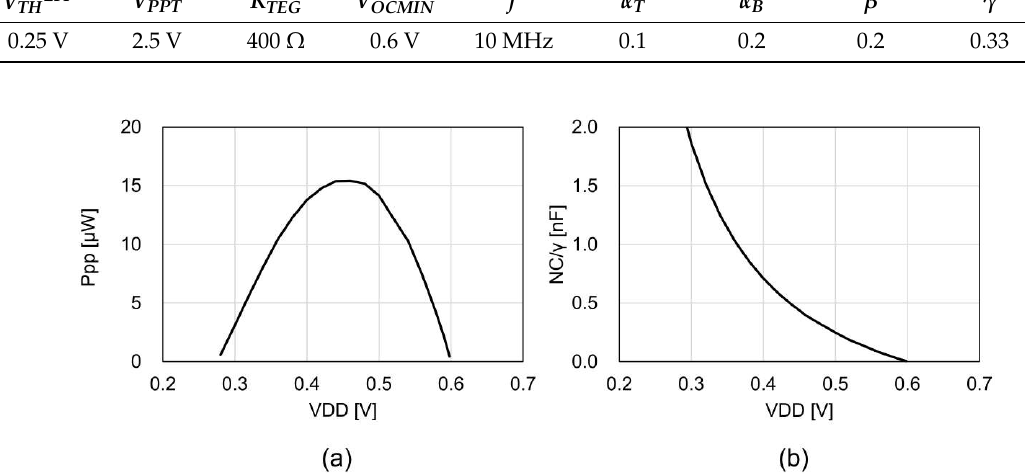
Figure 5. ( a ) P PP vs. V DD ; ( b ) CP area NC/ g vs. V DD